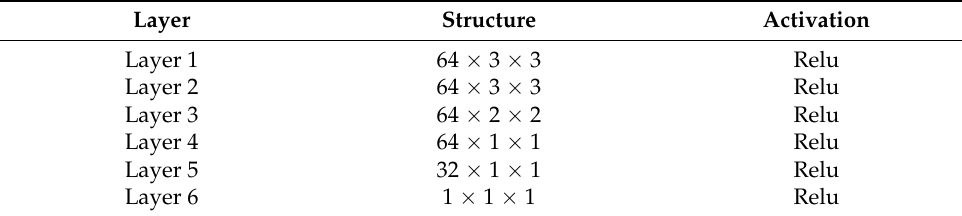
Table 2. Vehicle matching network—matching network